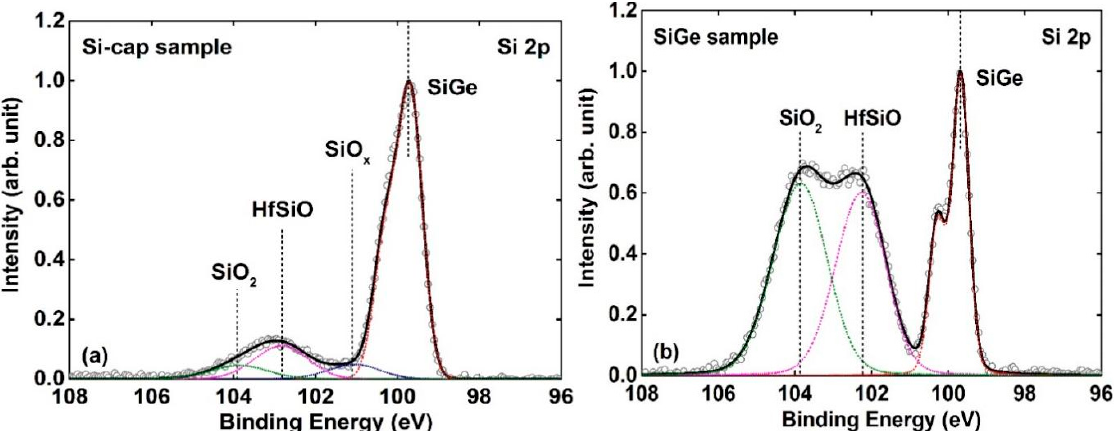
Figure 7. The fitted Si 2p core ‐ level spectra of ( a ) Si ‐ cap sample ( b ) SiGe sample. The red, blue, magenta, and green dot lines denote the Si 2p of SiGe, SiO x , HfSiO, and SiO 2 , respectively.